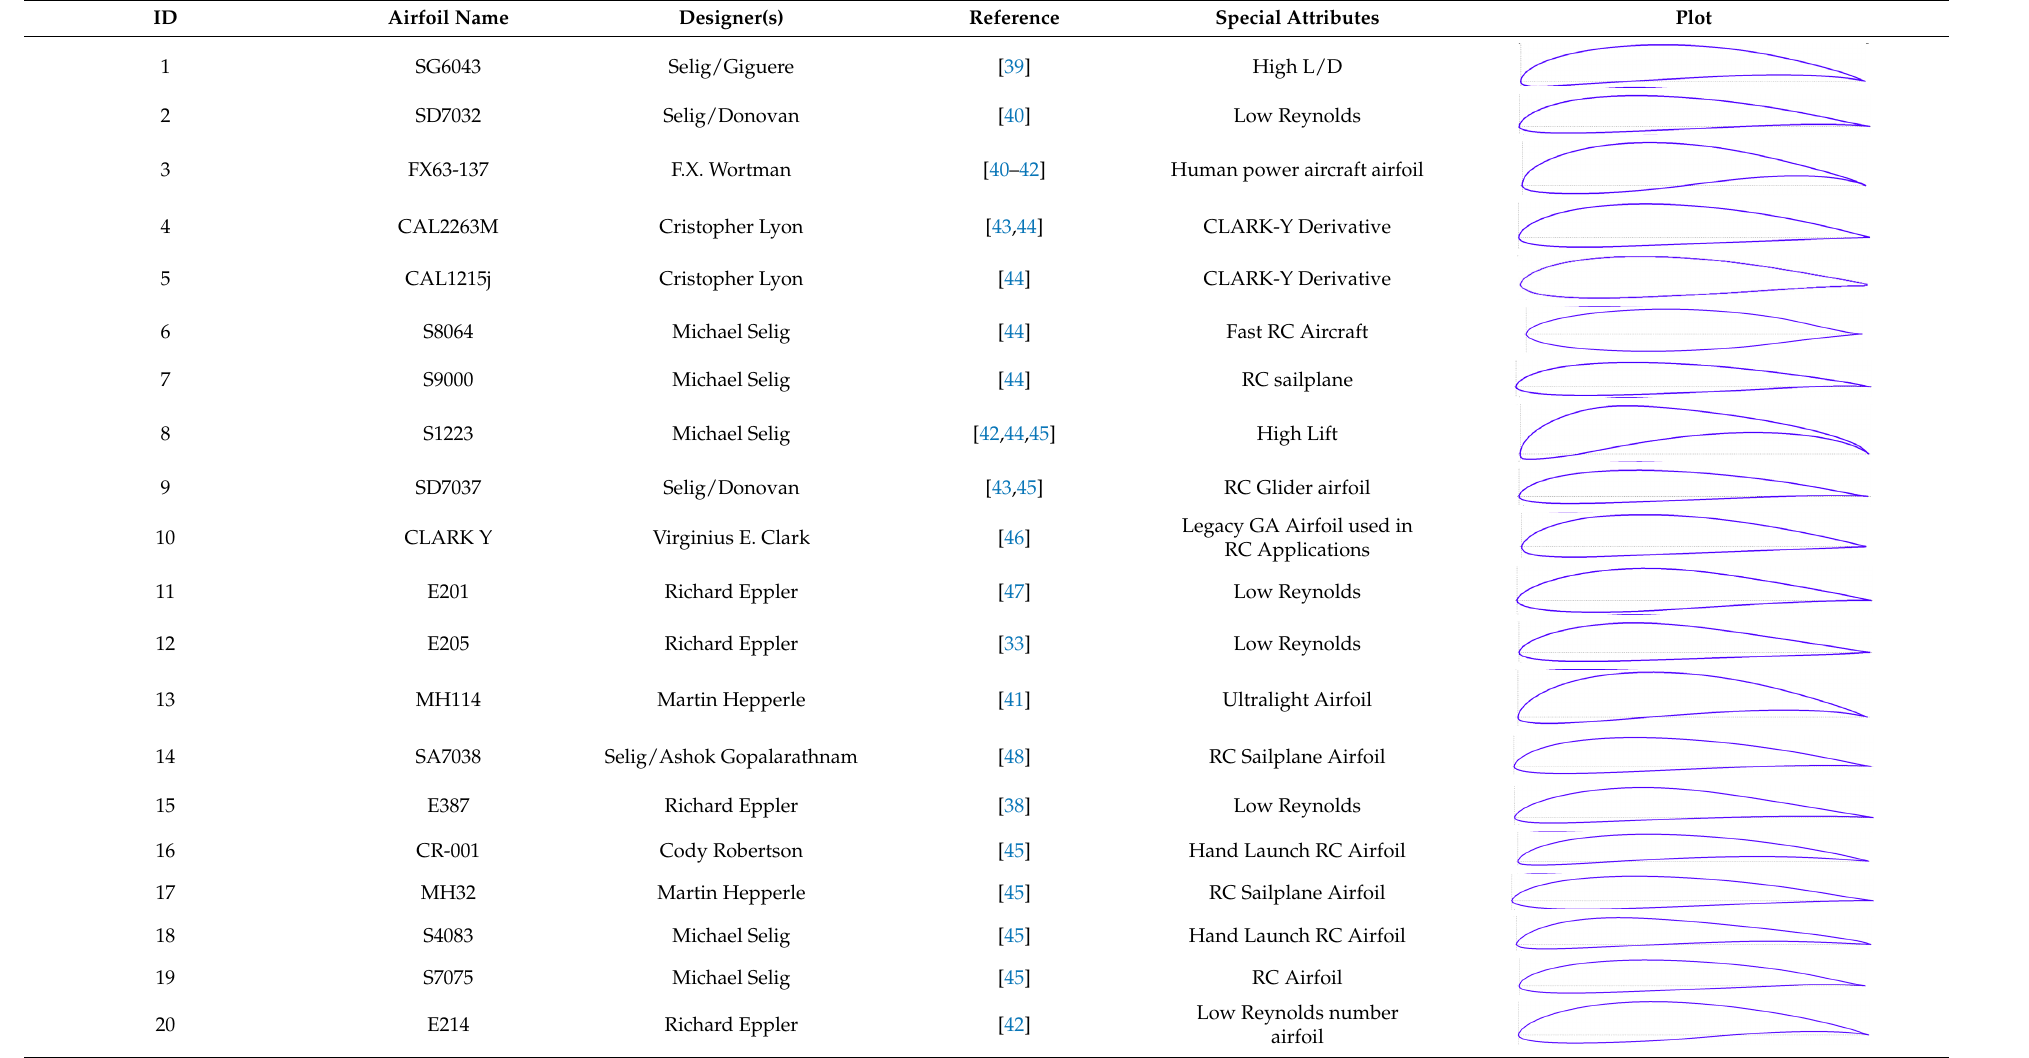
Table 5. The twenty airfoils